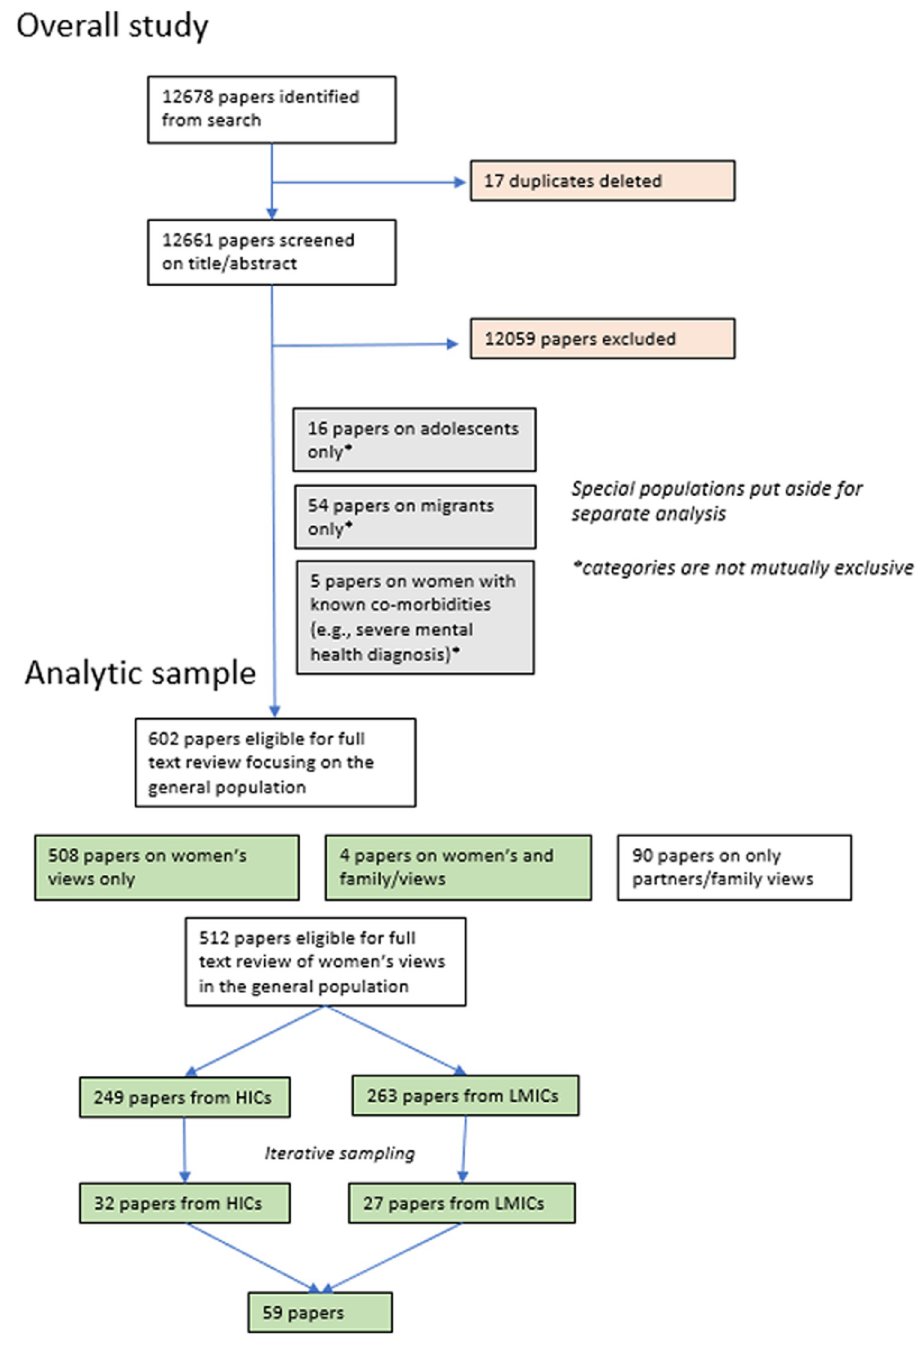
Fig 1. Flow diagram of included